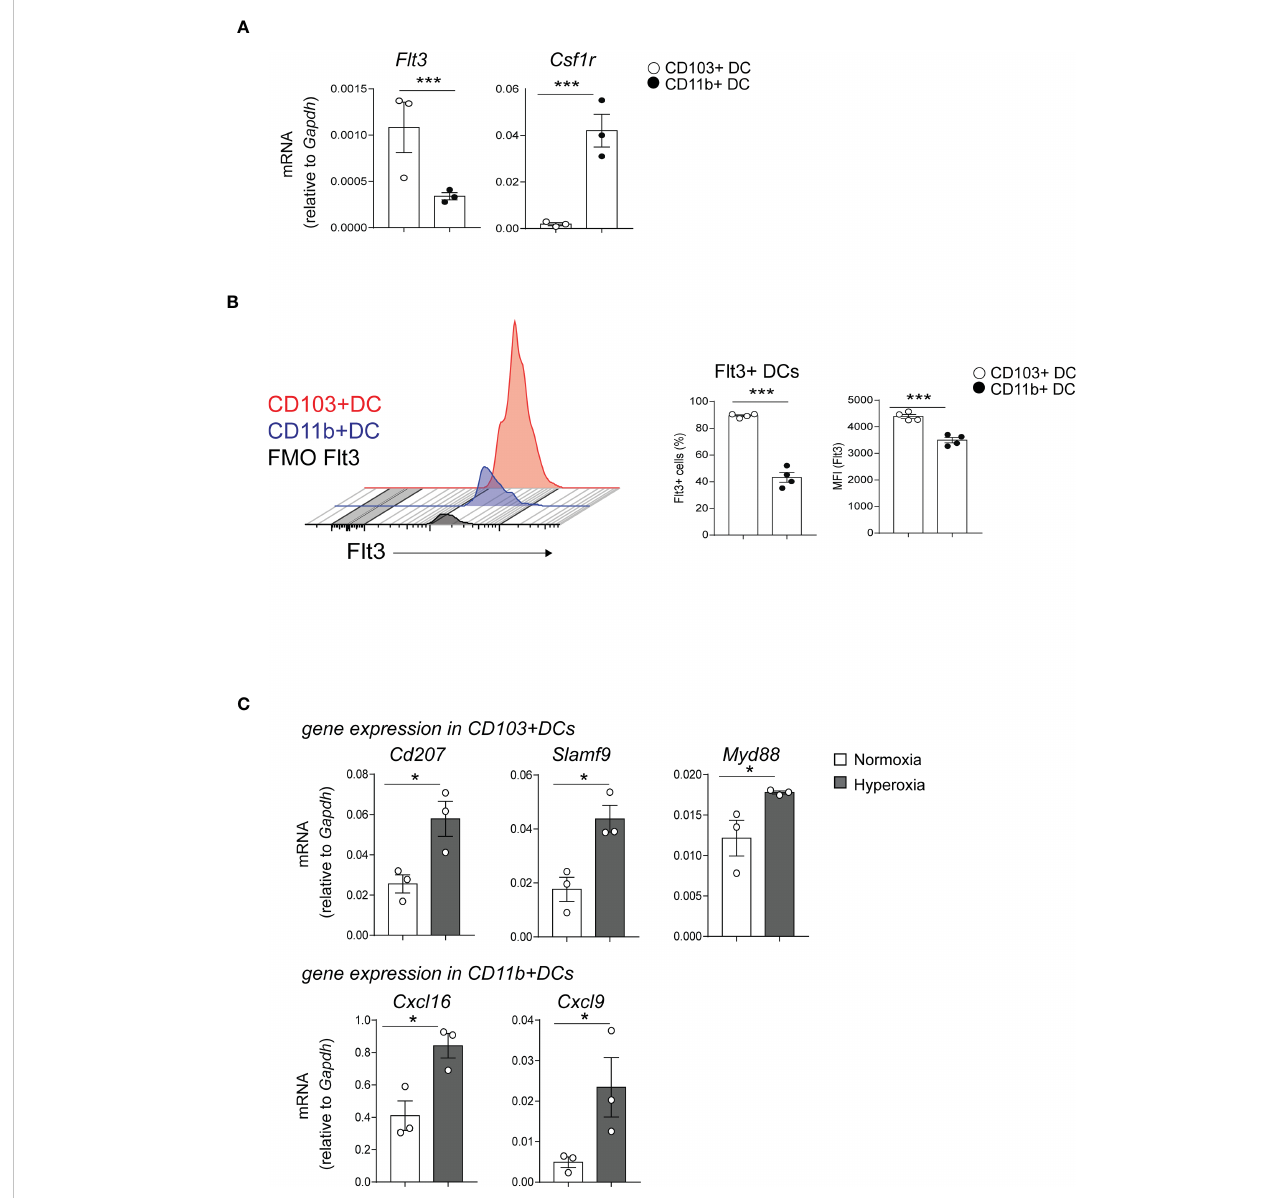
FIGURE 3 Differentially expressed genes in CD103+ DCs and CD11b hi DCs determine their development and immune function. (A) Flt3 and Csf1r mRNA expression was quanti fi ed by qPCR in CD103+ DCs (white circle) or CD11b hi DCs (black circle), fl ow sorted from normoxia-exposed neonatal lungs (DOL16). Each sample contains sorted cells from two separate neonatal mouse lungs. Unpaired t -test was performed to test the signi fi cance. *** indicates p<0.001. (B) Histograms demonstrate Flt3 protein expression in CD103+ DCs (red) and CD11b+ DCs (blue). Unstained control (de fi ned by FMO) is presented in gray. The fraction of Flt3+ CD103+ DCs (open circle) or CD11b hi DCs (black circle) in neonatal lung (DOL 9) was de fi ned by fl ow cytometry analysis. Mean Florescence Intensity (MFI) of Flt3 was also quanti fi ed. These results are representative of two independent experiments. Unpaired t -test was performed to test the signi fi cance. *** indicates the signi fi cant level p<0.001. (C) . CD103+ DCs and CD11b hi DCs were fl ow sorted from neonatal lungs after 14-day exposure to normaxia (open bar) or hyperoxia (black bar). Selected differentially expressed genes in CD103+ DCs (CD207, SlamF9 and Myd88) and in CD11b hi DCs (CXCL16 and CXCL9) were quanti fi ed with qPCR. Each sample contains sorted cells from two separate neonatal mouse lungs. Total number of six neonatal mouse lungs per group were studied. * P <0.05 (unpaired t